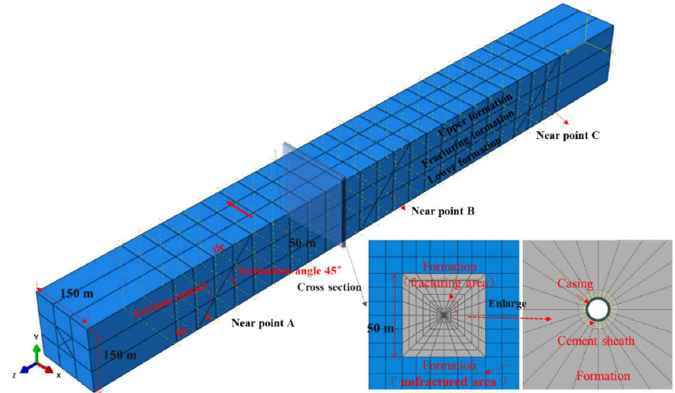
Figure 6. Casing deformation calculation model with faults.